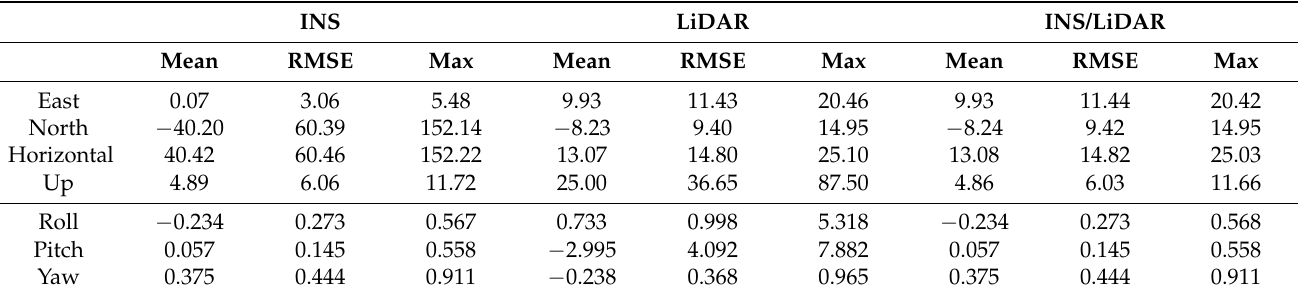
Table 4. D-101—position (m) and attitude (deg) error statistics.